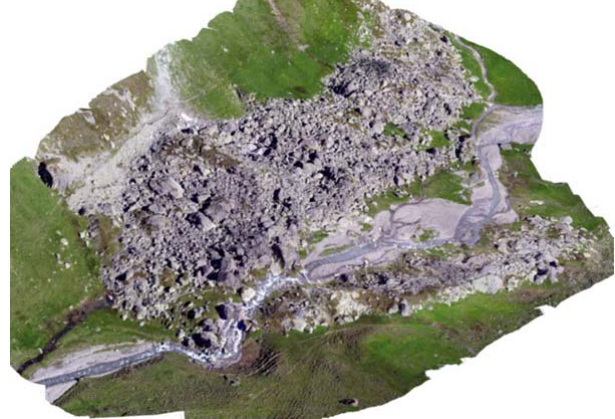
Figure 8: DSM Overlaid with its Orthophoto